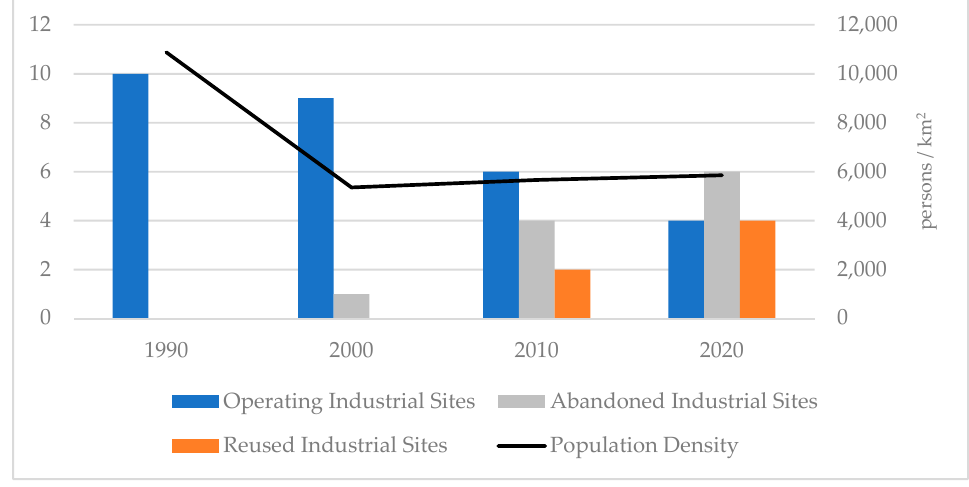
Figure 23. The change in the relationship between the operation state of technology-intensive industries and the population density over time (Figure source: own drawing; data from: [84]).